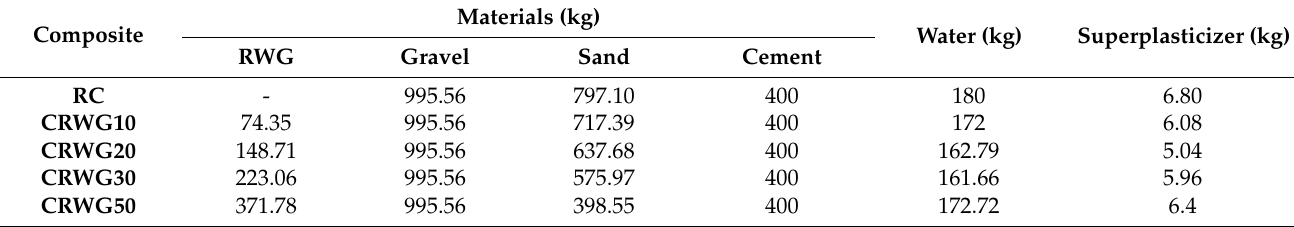
Table 3. Mass of each constituent in 1 m 3 of each formulation of concrete reinforced with